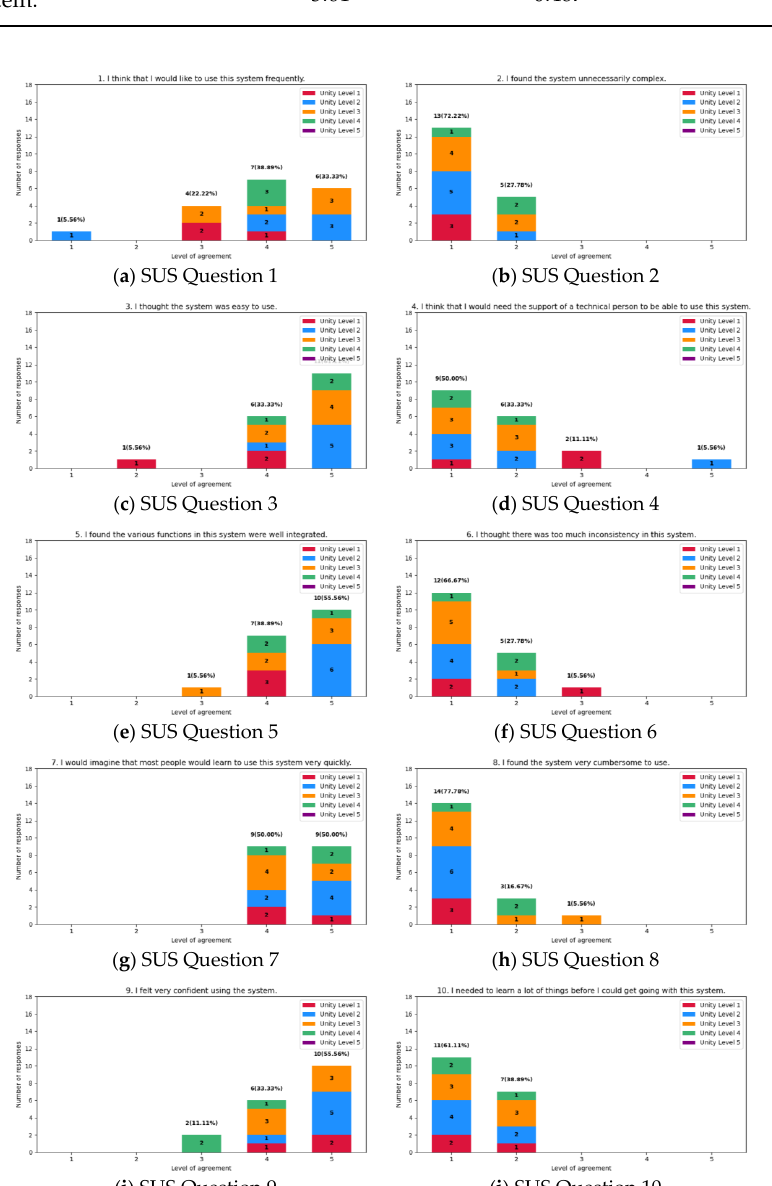
Figure 8. SUS answers per question.